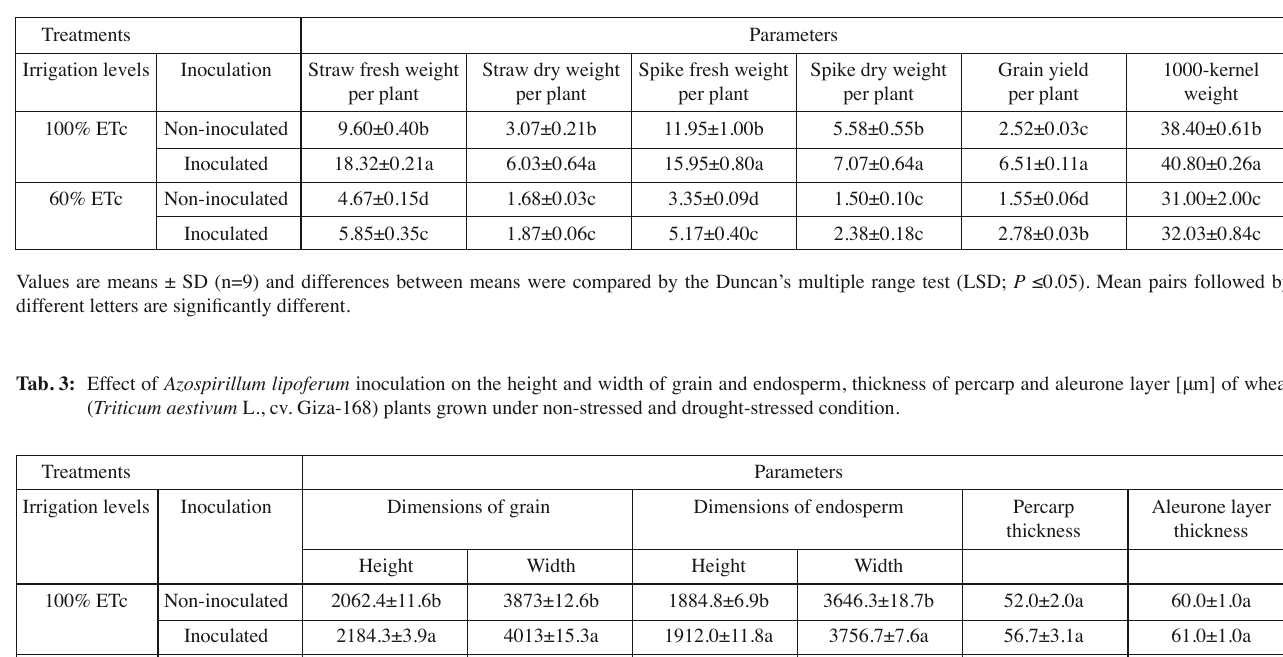
Tab. 2: Effect of Azospirillum lipoferum inoculation on the yield component [straw fresh weight per plant (g), straw dry weight per plant (g), spike fresh weight per plant (g), spike dry weight per plant (g), grain yield per plant (g) and 1000-kernel weight (g)] of wheat ( Triticum aestivum L., cv. Giza-168) plants grown under non-stressed and drought-stressed